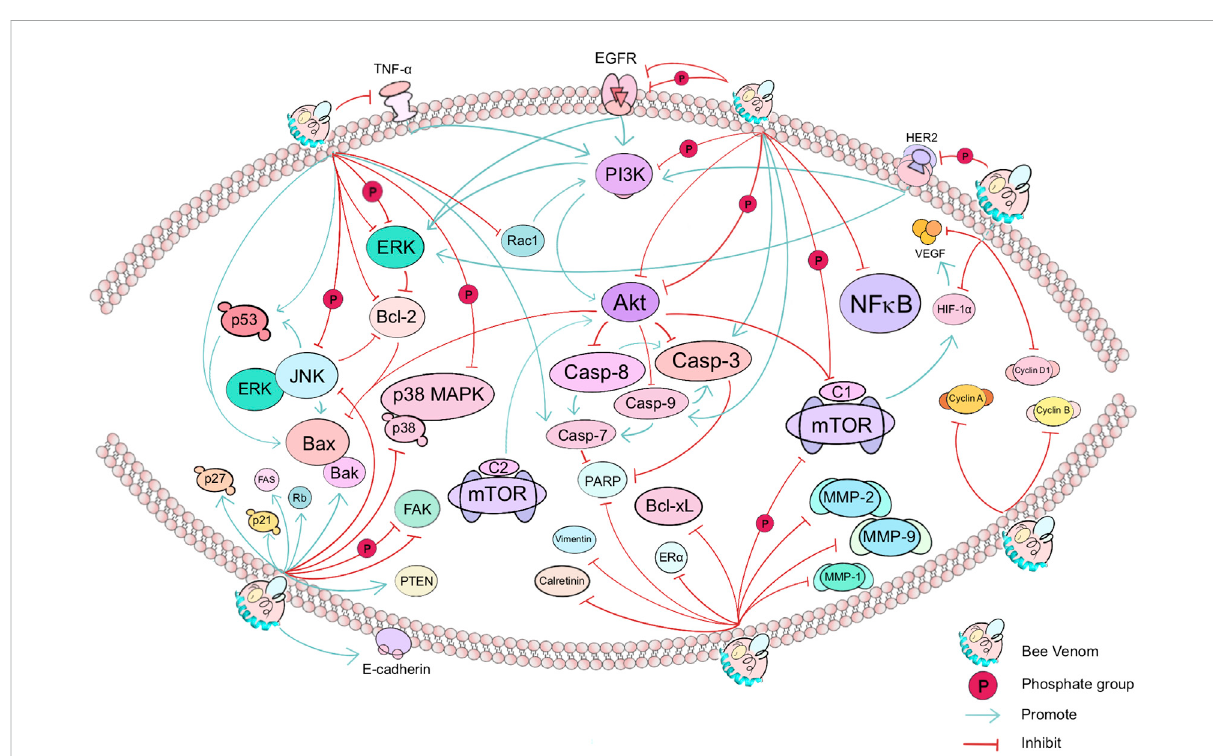
FIGURE 2 ThemainaffectedtargetsandpathwaysinanticancereffectsofBV.Incancer,BVmainlyaffectsthePI3K/Akt/mTORpathway(e.g.,PI3K,Akt,and mTOR),apoptosissignalingpathway(e.g.,EGFRandTNF- α ,includingdownstreameffectorssuchasCasp-3,Casp-7,Casp-8,Casp-9,Bcl-2,Baxand Bcl-xL), p38 MAPK pathway, and thus affect the growth, differentiation, invasion, autophagy or migration of cancer cells in lung, breast, cervical and othercancers.Greenarrowsorredcut-offlinesrepresentthe “ promote ” or “ inhibit ” effectofthetarget(geneorprotein)bytheupstreamtarget